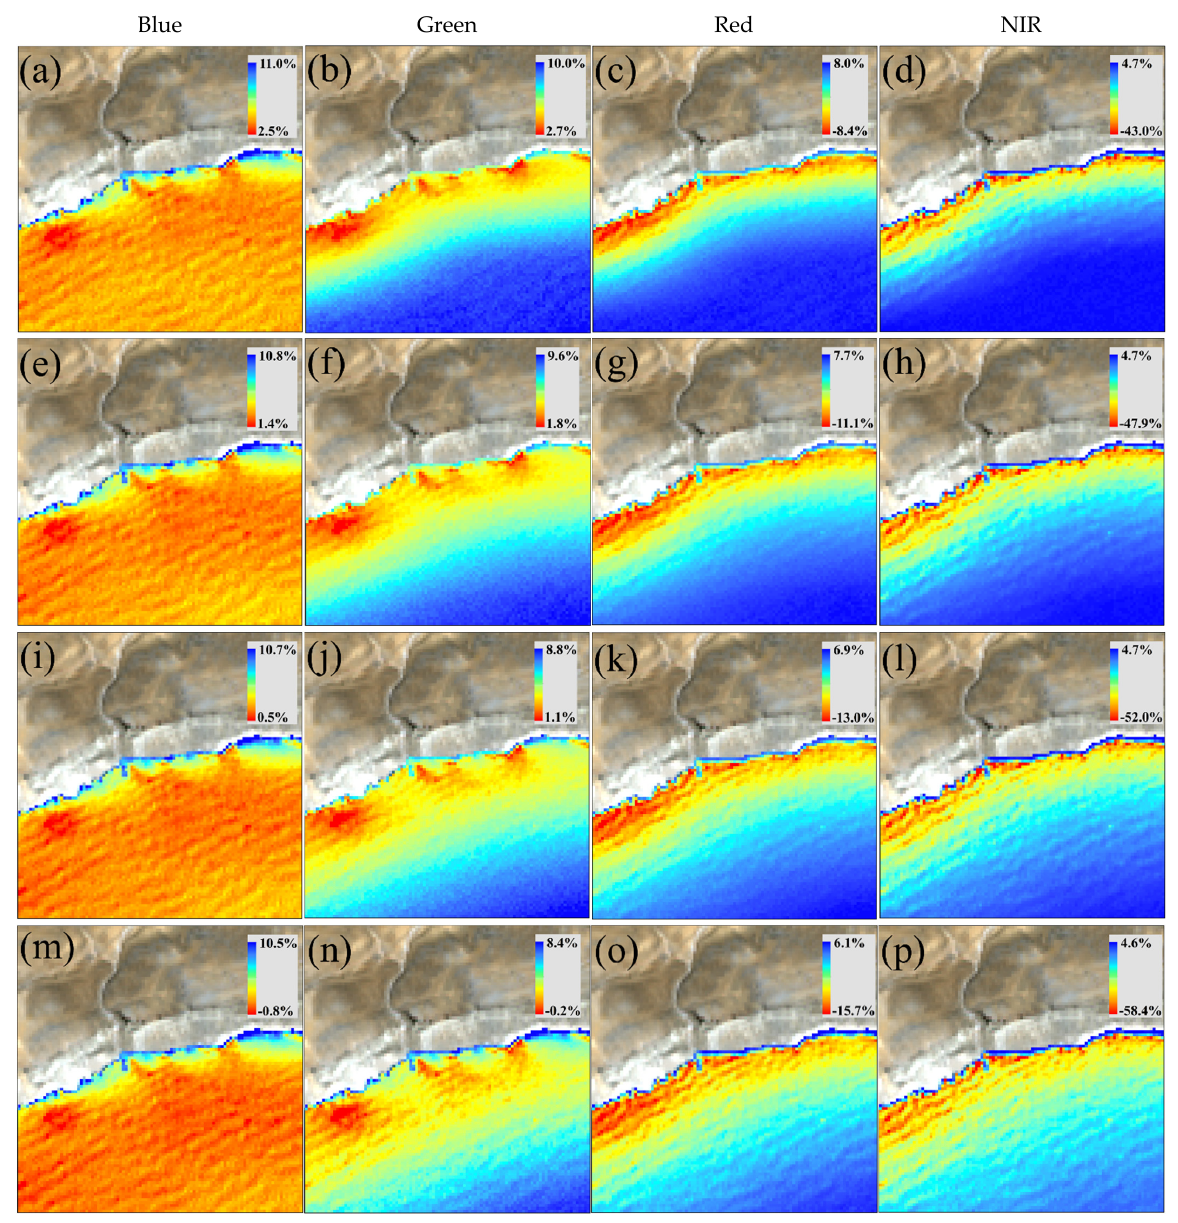
Figure 6. Distribution of R rc by the band for Mixed Zone in Socotra. ( a – d ) are R ns = 1 km, ( e – h ) are R ns = 1.5 km, ( i – l ) are R ns = 2 km, and ( m – p ) are R ns = 3 km. The differences between the two models in the blue, green, red, and NIR bands are shown.